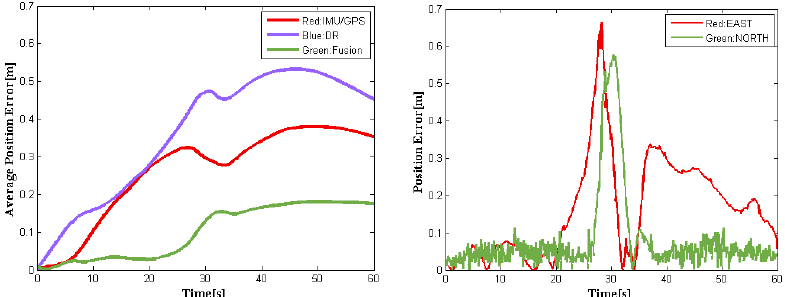
Figure 6. Average position error curves ( Left ) evaluated using IMU–GPS, DR, and our data fusion method. Errors in position are obtained as the norm of difference between the ground truth and the fusion data at each time step ( Right ).